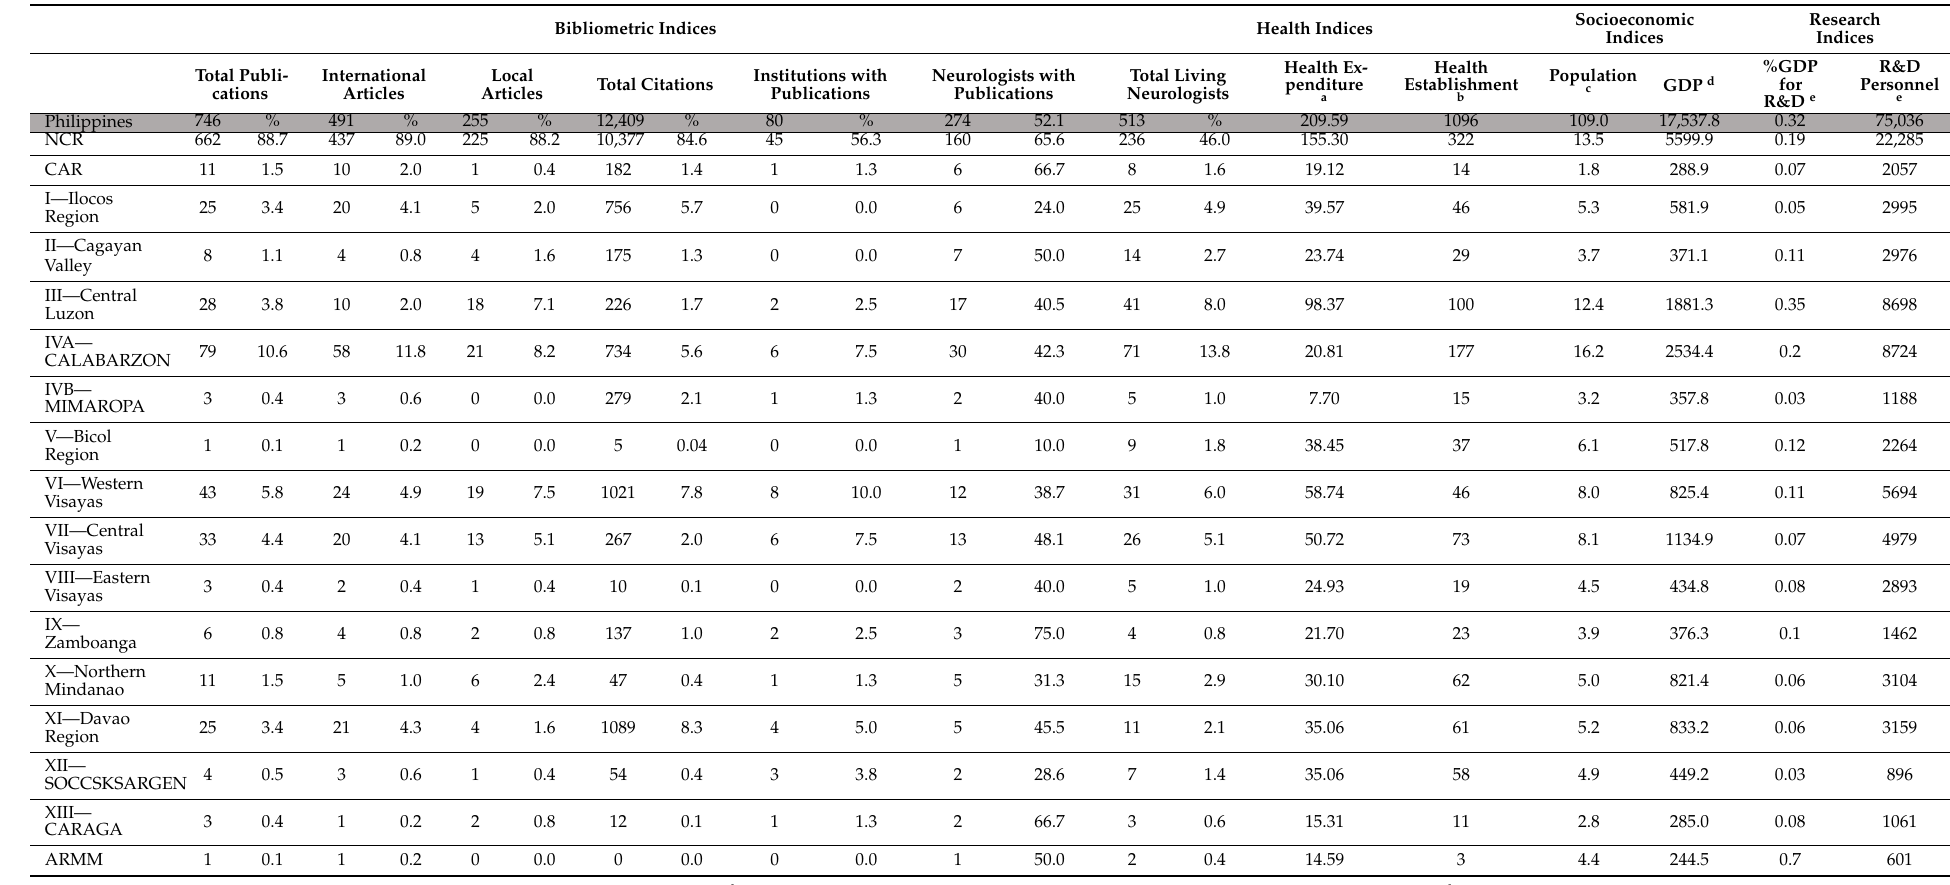
Table 1. Bibliometric indices, socioeconomic factors, healthcare and research indices of the Philippines and individual